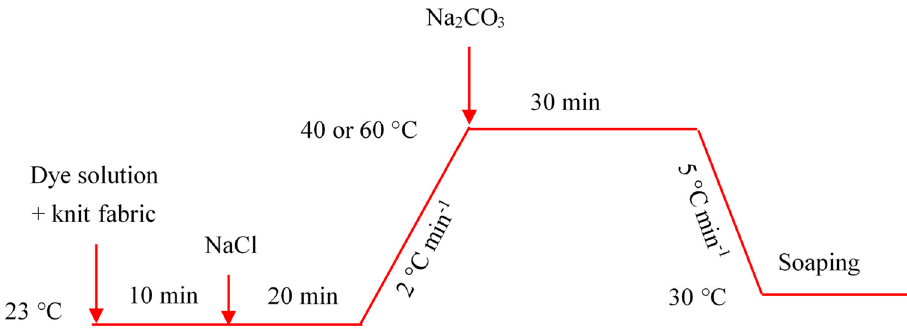
Figure 2. Dyeing methodology of knit cotton fabric with Red 2 and Red 195 dyes.